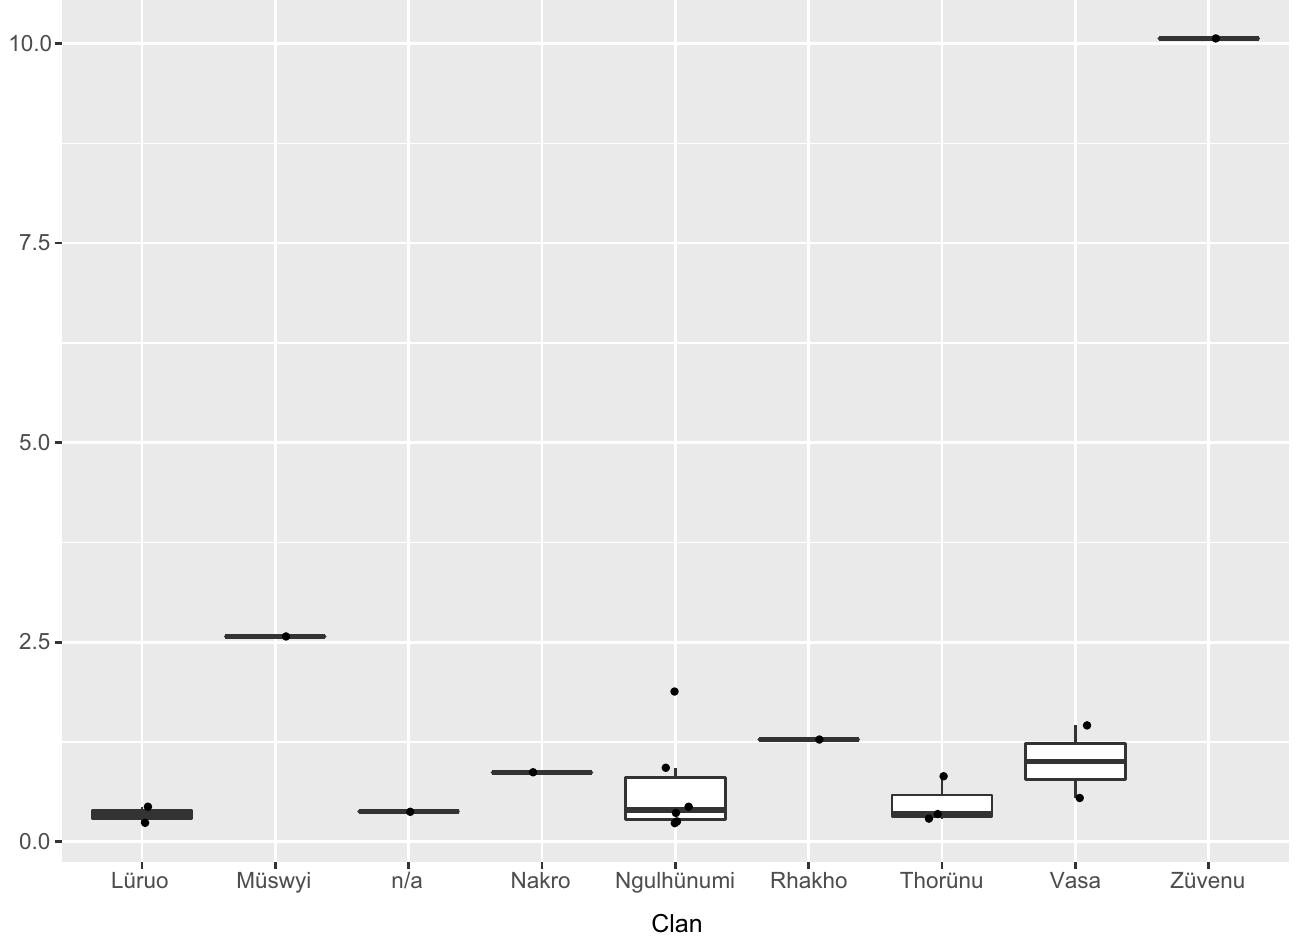
Fig 11. The size of the different monuments per type belonging to the various clans in the Chakhesang Naga village of Ru¨nguzu (graphic: M. Wunderlich).